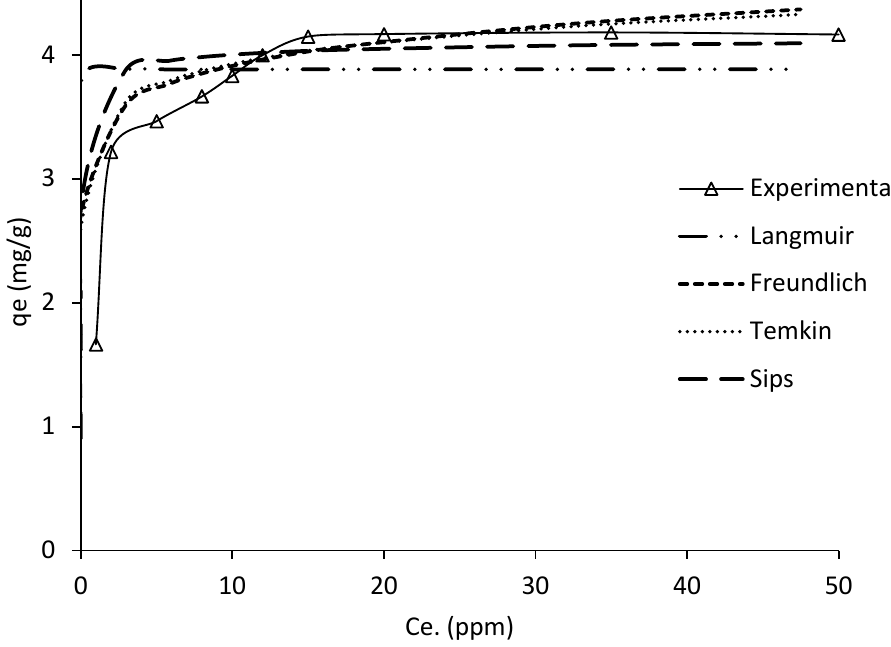
Figure 12. Adsorption isotherm modeling of Mo removal by the CDC. pH 5.2, CDC dosage of 0.6 g/L, and adsorption time of 1 h. Table 4. Isotherm parameters, correlation factors, and SSE of the tested models on Mo removal by the CDC.